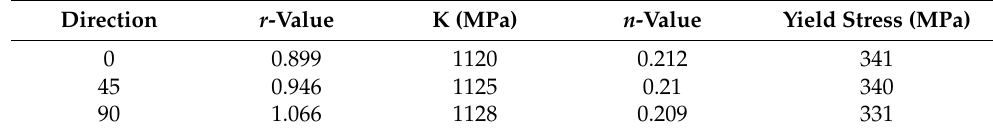
Table 2. Material parameters along different directions (high-strength